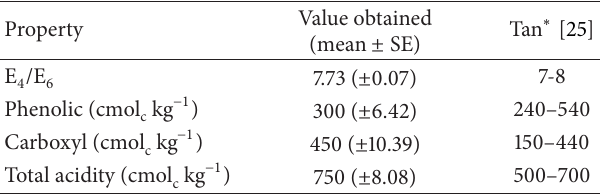
Table 4: Selected chemical properties of humic acid extracted from